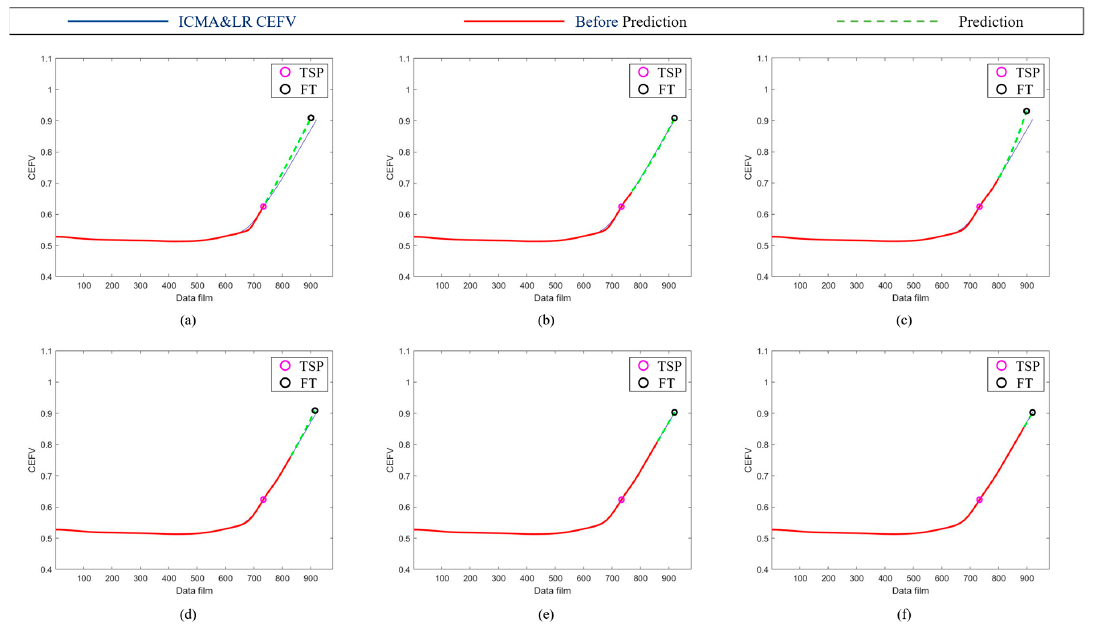
Figure 11. Trajectories of bearings’ health indicators using norm values. The trajectory was generated at different time points: ( a ) 7400, ( b ) 7700, ( c ) 8000, ( d ) 8300, ( e ) 8600, and ( f ) 8900 min.